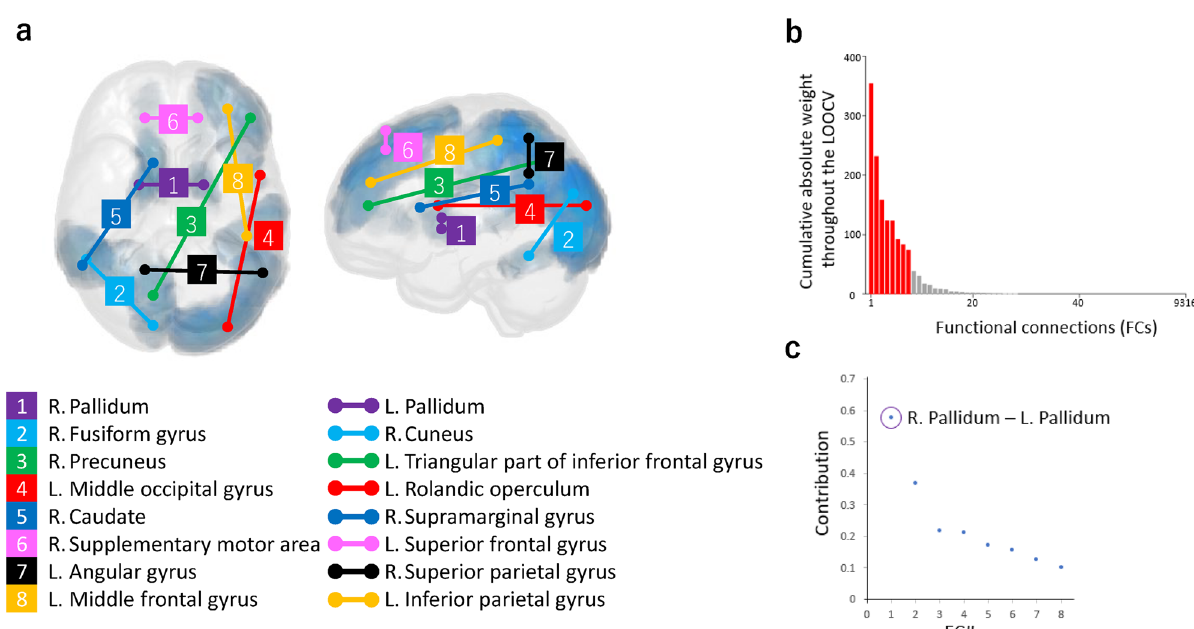
Figure 1. The eight identified functional connections (FCs) for the subthreshold depression (StD) classifier. ( a ) The 16 brain regions connected by the eight FCs of the StD biomarker (rendered with: MRIcroGL 64-bit, June 12, 2015, https:// www. nitrc. org/ proje cts/ mricr ogl). ( b ) Contribution of individual FCs to the StD biomarker. The cumulative absolute weights are shown for all 9316 FCs, of which 29 FCs were selected at least once throughout the leave-one-out cross validation process. The eight FCs identified through the StD classifier were derived from a key subset of the 29 FCs (the red columns represent the eight identified FCs, and the gray columns represent the remaining 21 FCs). ( c ) Contribution of each of the eight FCs to the StD